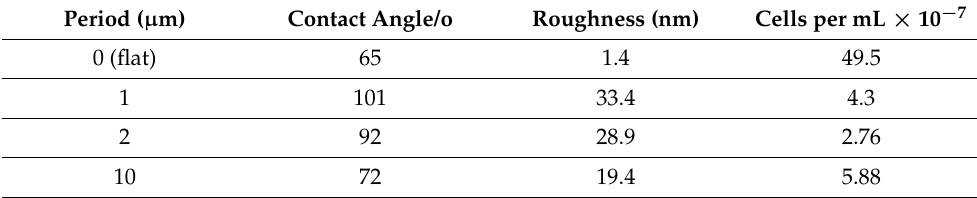
Table 3. Effect of DLIP structuring of a PI surface on the growth of bacterial cells. Period ( µ m) Contact Angle/o Roughness (nm) Cells per mL × 10 −